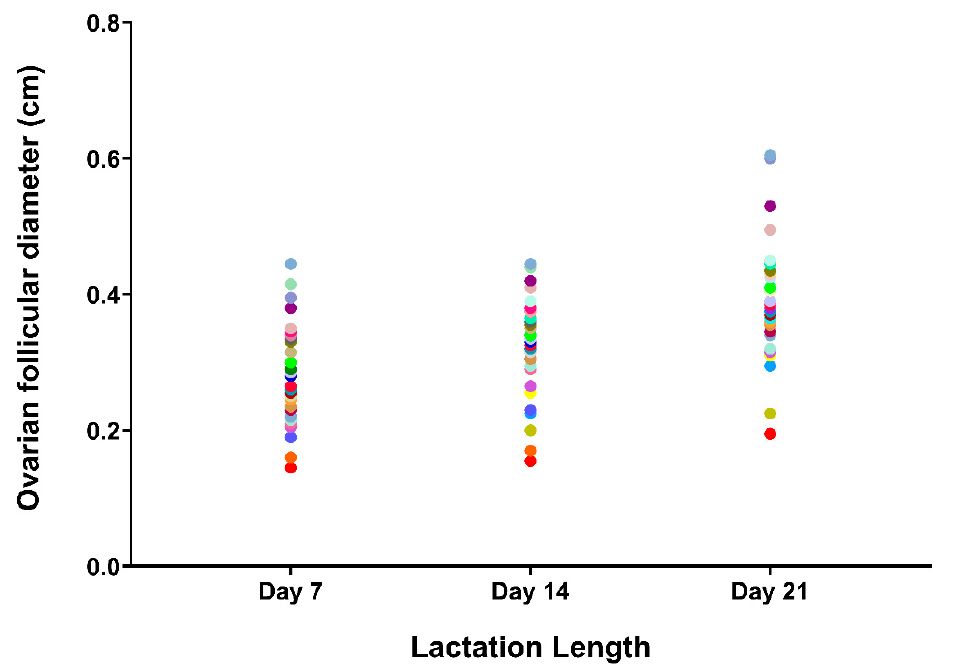
Figure 4. Mean diameter of ovarian follicles in nursing sows ( n = 40) measured three times throughout the lactation period. Sows are shown with the same color point in the three measurement times.